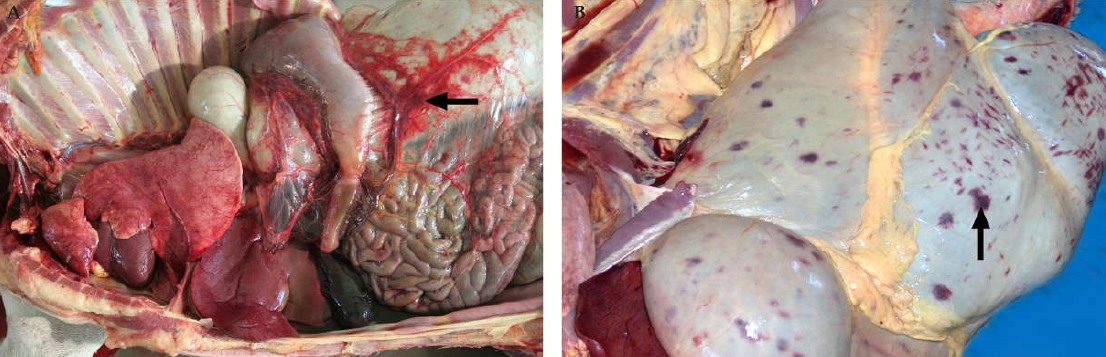
Figure 13. Omentum and rumen of an RVFV-infected adult sheep. ( A ) Marked congestion of the omental blood vessels with petechiae along the vessels and in the omental fat (arrow). ( B ) Petechiae and ecchymoses in the serosa of the rumen (arrow).